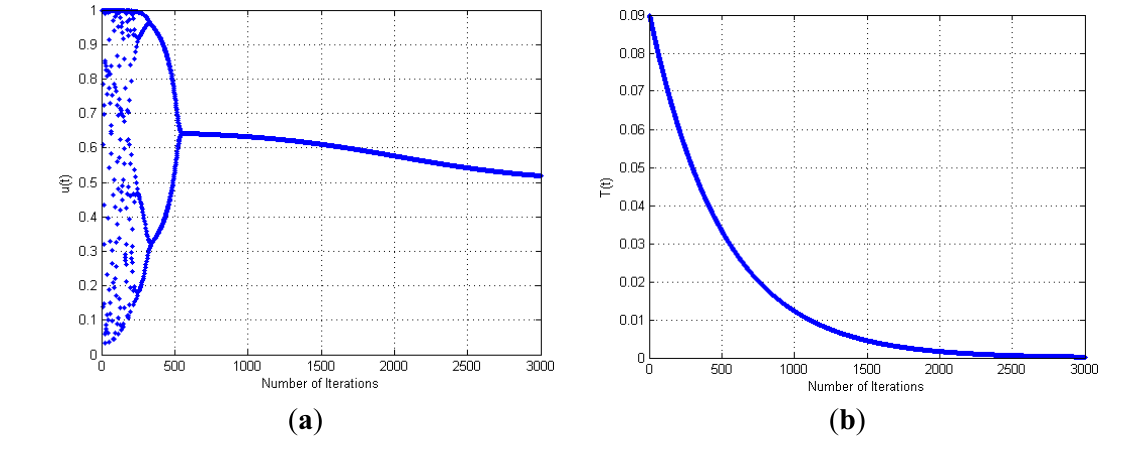
Figure 4. ( a ) Output of single neuron (t) u ; ( b ) Self-feedback connection weight (t) T